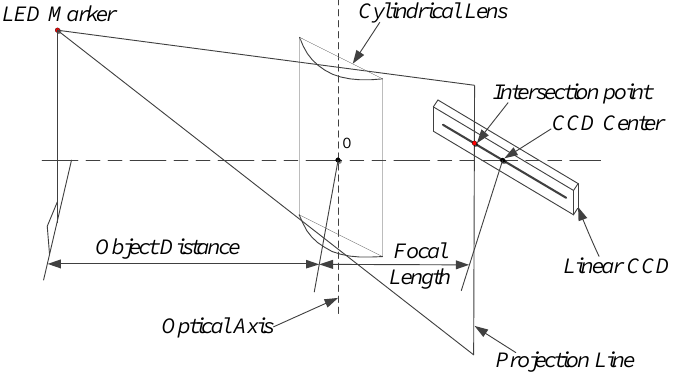
Figure 1. Projection mapping model of the one-dimensional imaging unit.